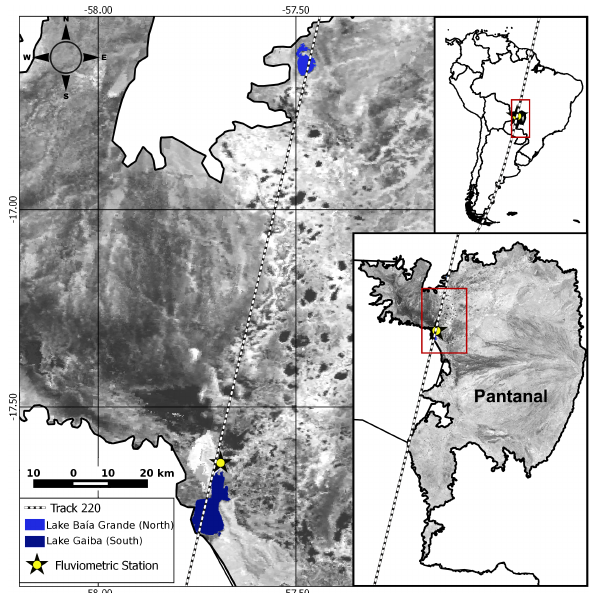
Figure 2: General views of the study area shownig the two lakes investigated. A MODIS image in the backdrop shows the extent of the water surface covering the region (dark